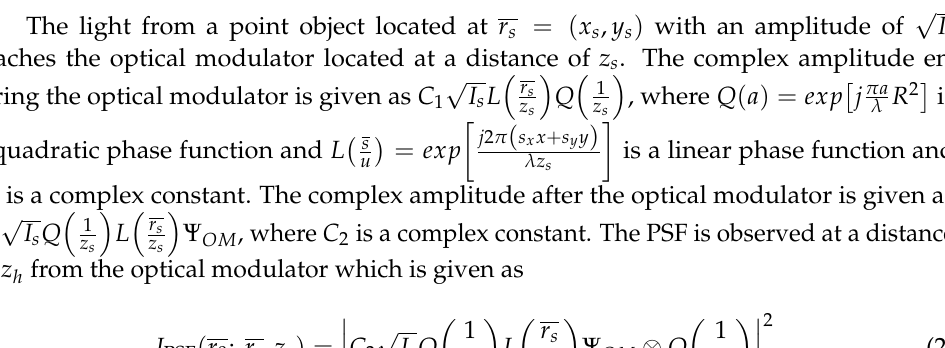
(cid:104) (cid:105) − j 2 π R , there is always an annular region in the Λ 1 p